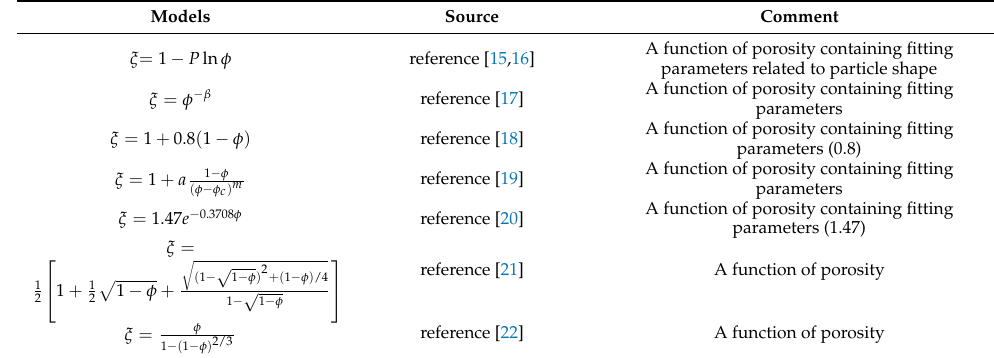
Table 1. Summary of published tortuosity